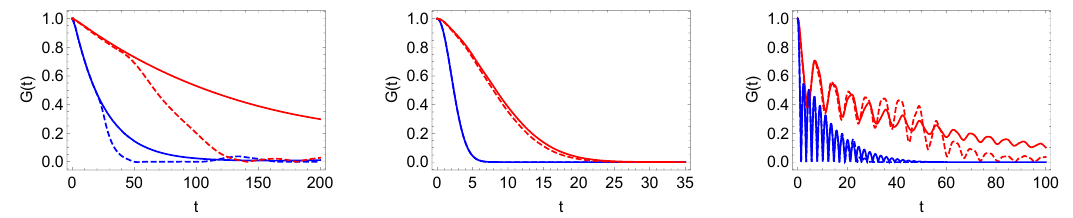
Figure 7: The Loschmidt echo L ( t ) ≡ | A ( t ) | 2 in the thermodynamic limit calculated using the Fredholm determinant representation (32) (solid lines). The blue (red) color corresponds to the full initial filling (initial particle density Φ /π = 1 / 3) of the left. The left, middle and right panels correspond to (cid:34) = 0.3, (cid:34) = 1.0 and (cid:34) = 2.4, respectively. Dashed lines corresponds to the Loschmidt echo in finite system with = 10 for the full filling and N = 6 for the filling N f f